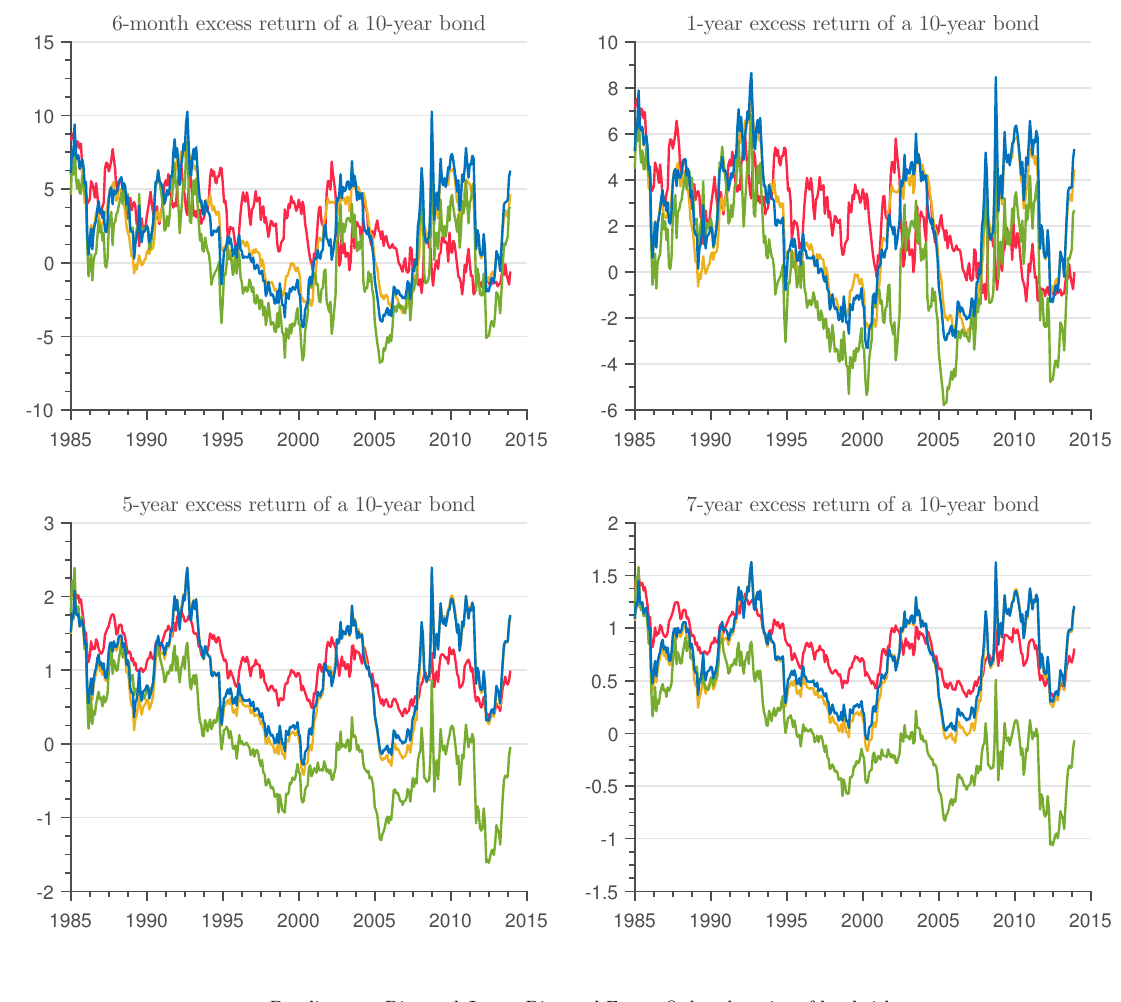
Figure 5. Expected returns on a 10-year bond: different models and holding